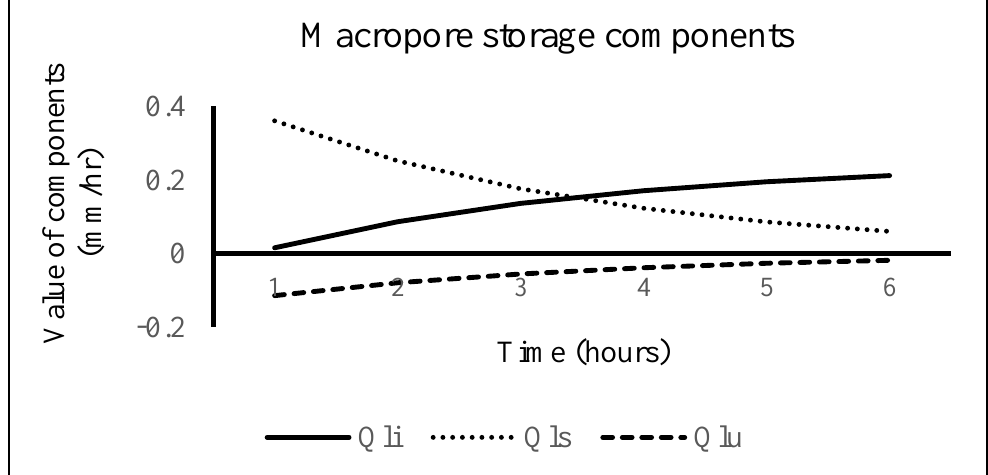
Figure 13. Change in macropore storage with respect to time for 100 mm/h rainfall intensity. Soil matrix; Q li : lateral exfiltration out of the saturated soil matrix by interflow out of a zone with perched groundwater; Q ls : lateral exfiltration out of the saturated soil matrix; Q lu : lateral infiltration into the unsaturated soil matrix.